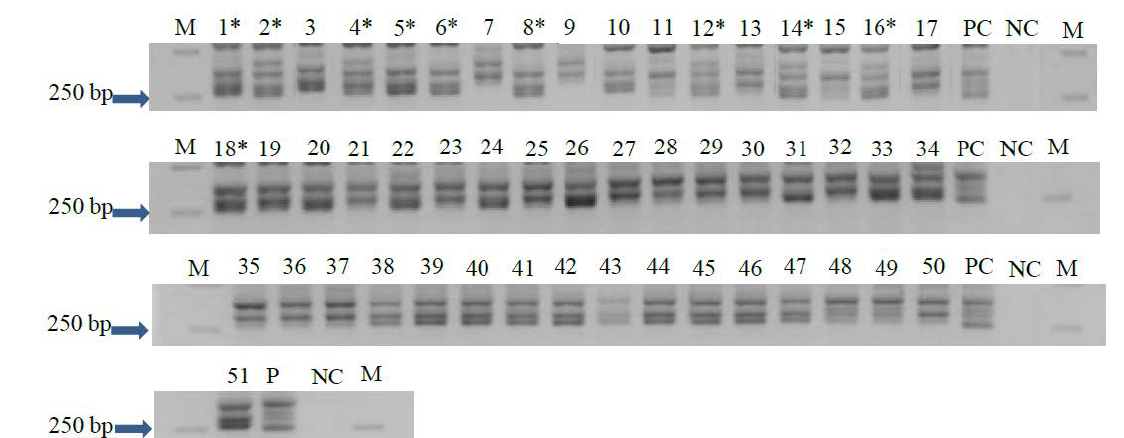
Fig. 3. PCR amplification of Pl 16 with the expected size of 250 bp (as indicated by arrow) using ORS1008 primer pairs in 51 inbred lines. The 1, 2, 4, 5, 6, 8, 12, 14, 16 and 18 inbred lines (as indicated by asterisk) showed the expected band. M: 1Kb marker, PC: positive control, NC: negative